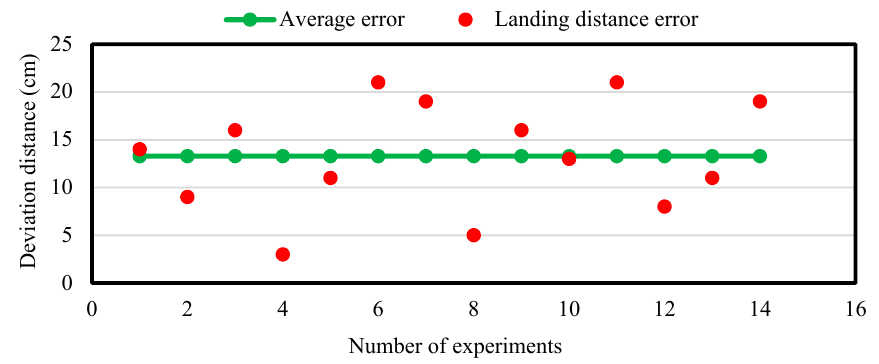
Figure 10. The error distribution of landing when the apron moves at 3 km/h. Horizontal axis is the number of experiments. Vertical axis is the distance from the center of the UAV landing position to the center of the image label. Red dot is the distance error. Green dot is the average error.